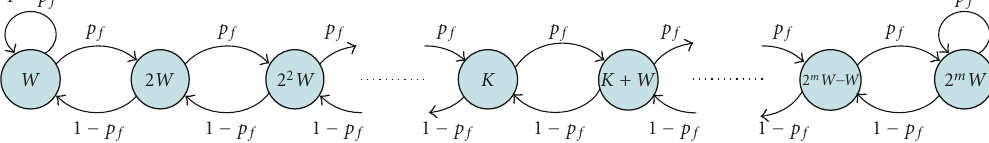
Figure 2: State transition diagram of semi-dynamic contention resolution